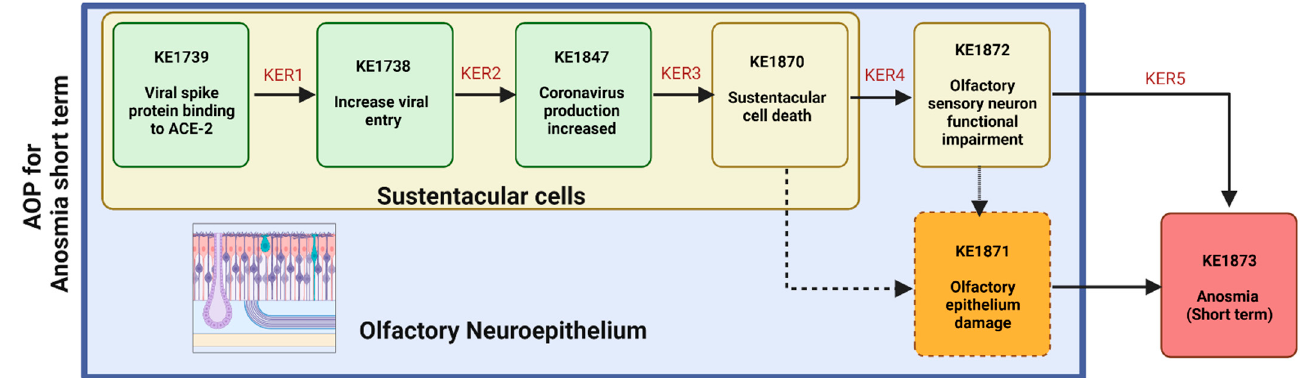
Figure 3. A putative AOP for anosmia induced by COVID-19 infection. KE—key event; KER—key event relationship. KE and KER refer to the AOP published at aopwiki.org/ (Accessed on 20 September 2022). Created with Biorender.com (Accessed on 20 September 2022).